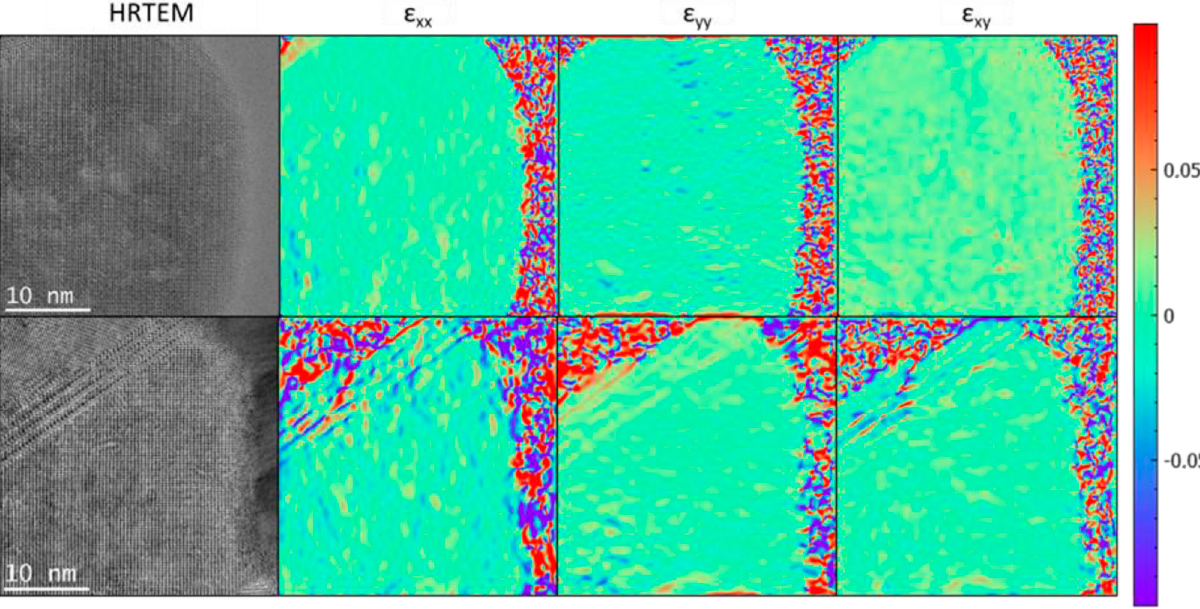
Figure 6. GPA strain profiles calculated from both samples on [110] zone axis orientation. The x axis corresponds to the [100] direction and the y axis to the [110] direction.